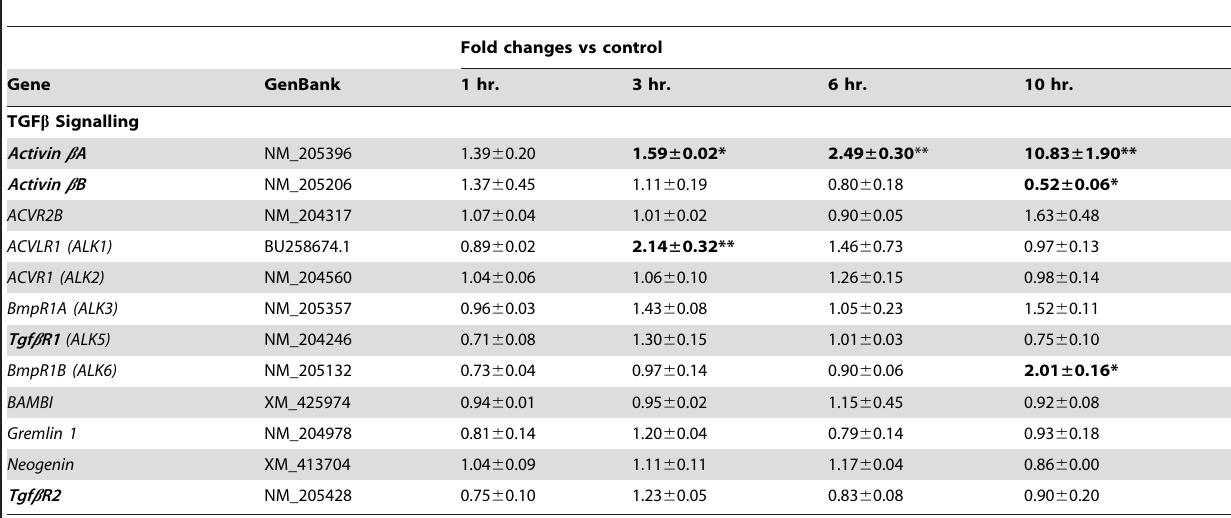
Table 4. Regulation of genes in the Tgf- b signaling pathway at 1, 3, 6, and 10 hr after interdigital implantation of beads bearing Tgf- b